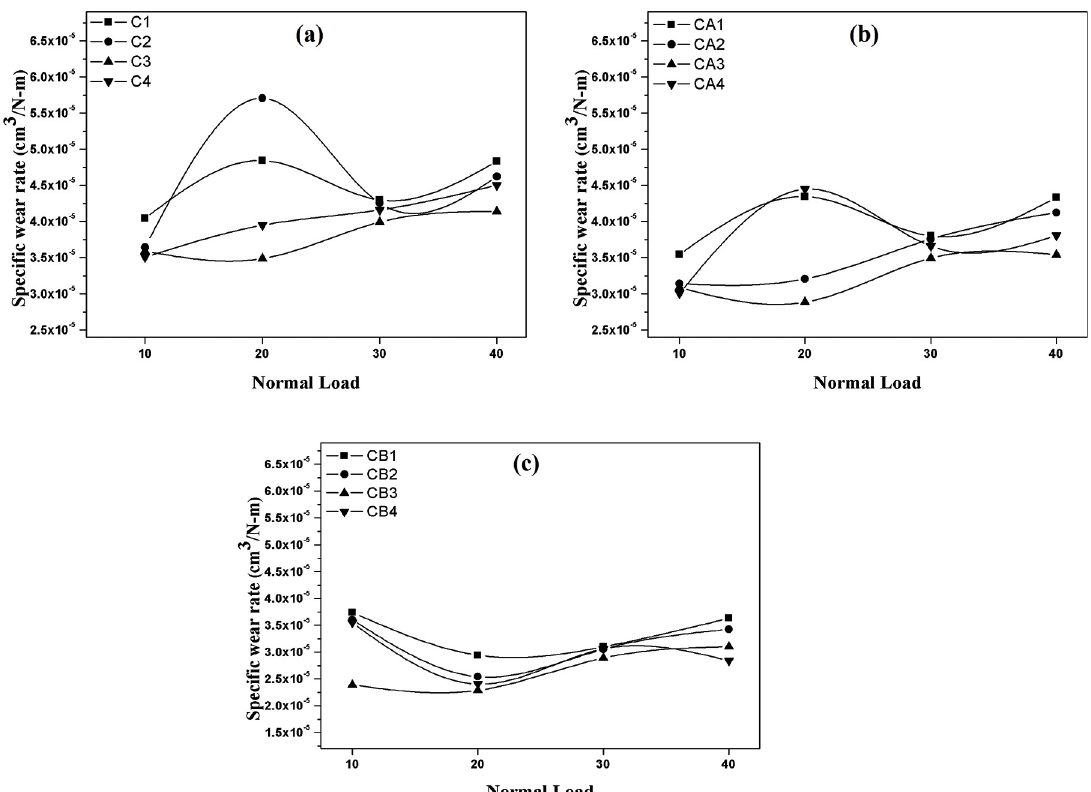
Figure 3. Effect of normal load on the specific wear rate for (a) Untreated (b) Alkali treated (c) Benzoyl chloride treated jute fiber-epoxy composites. (constant sliding distance: 50 m, and abrasive size: 300